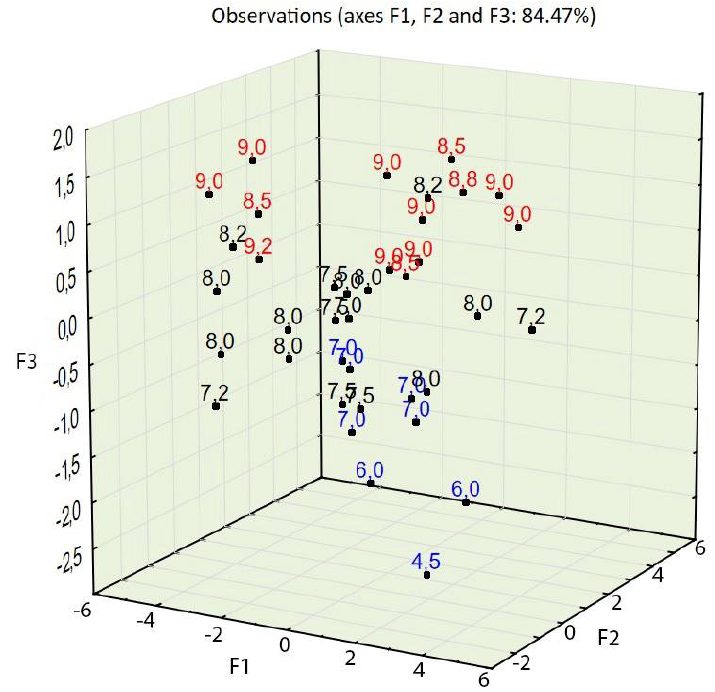
Figure 11. PCA with object grouping in a three-dimensional space on the basis of concrete compo- sition in relation to properties. Consistency: red represents 8.5 s or above, and blue represents 7 s or below.